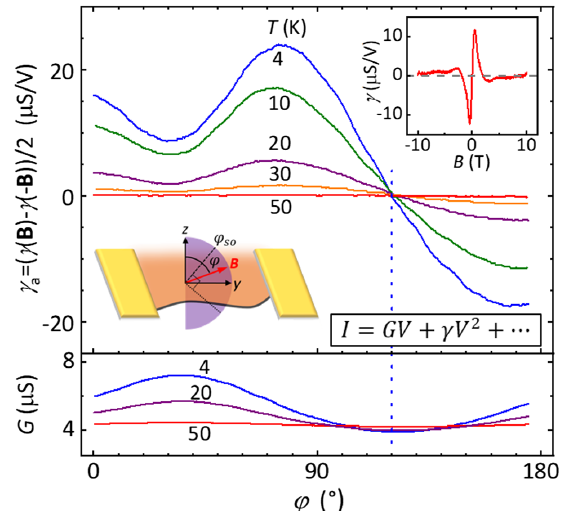
FIG. 4. Anisotropy of the nonlinear conductance. Simultaneous measurements of the field-antisymmetrized nonlinear coefficient γ (top) and linear conductance G (bottom) made as B is rotated a in the y - z plane at selected temperatures (contacts 1 and 2 in ¼ − 2 . 7 V, and ac bias 15 mV at f ¼ 101 Hz). device MW5, V g The field strength B ¼ 0 . 3 T is chosen to maximize γ . Inset: example of the variation of γ with B (see Fig. S10